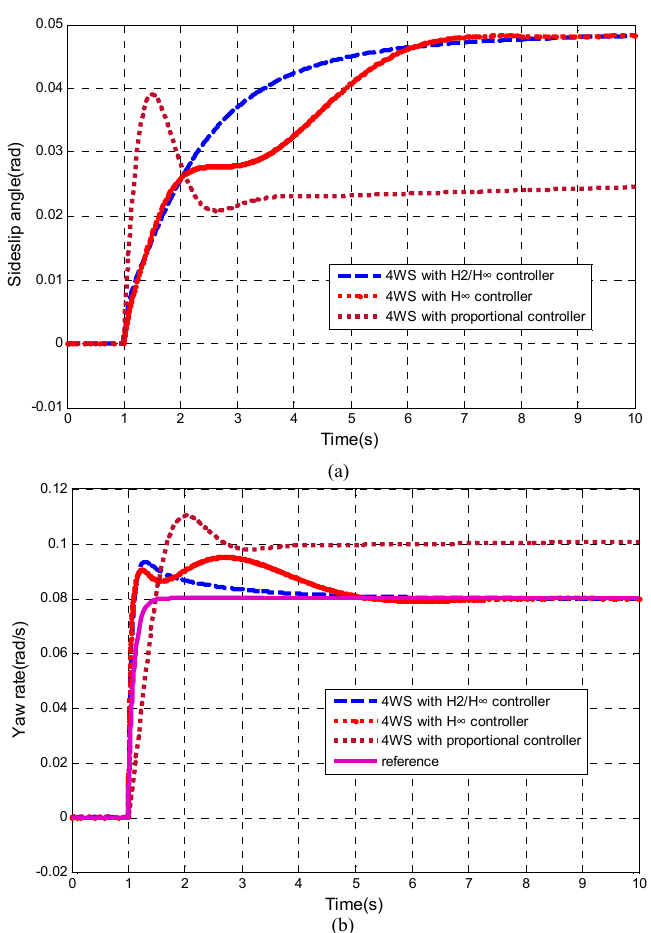
Figure 16. The step responses of the front wheel angle: ( a ) sideslip angle response; ( b ) yaw rate response.